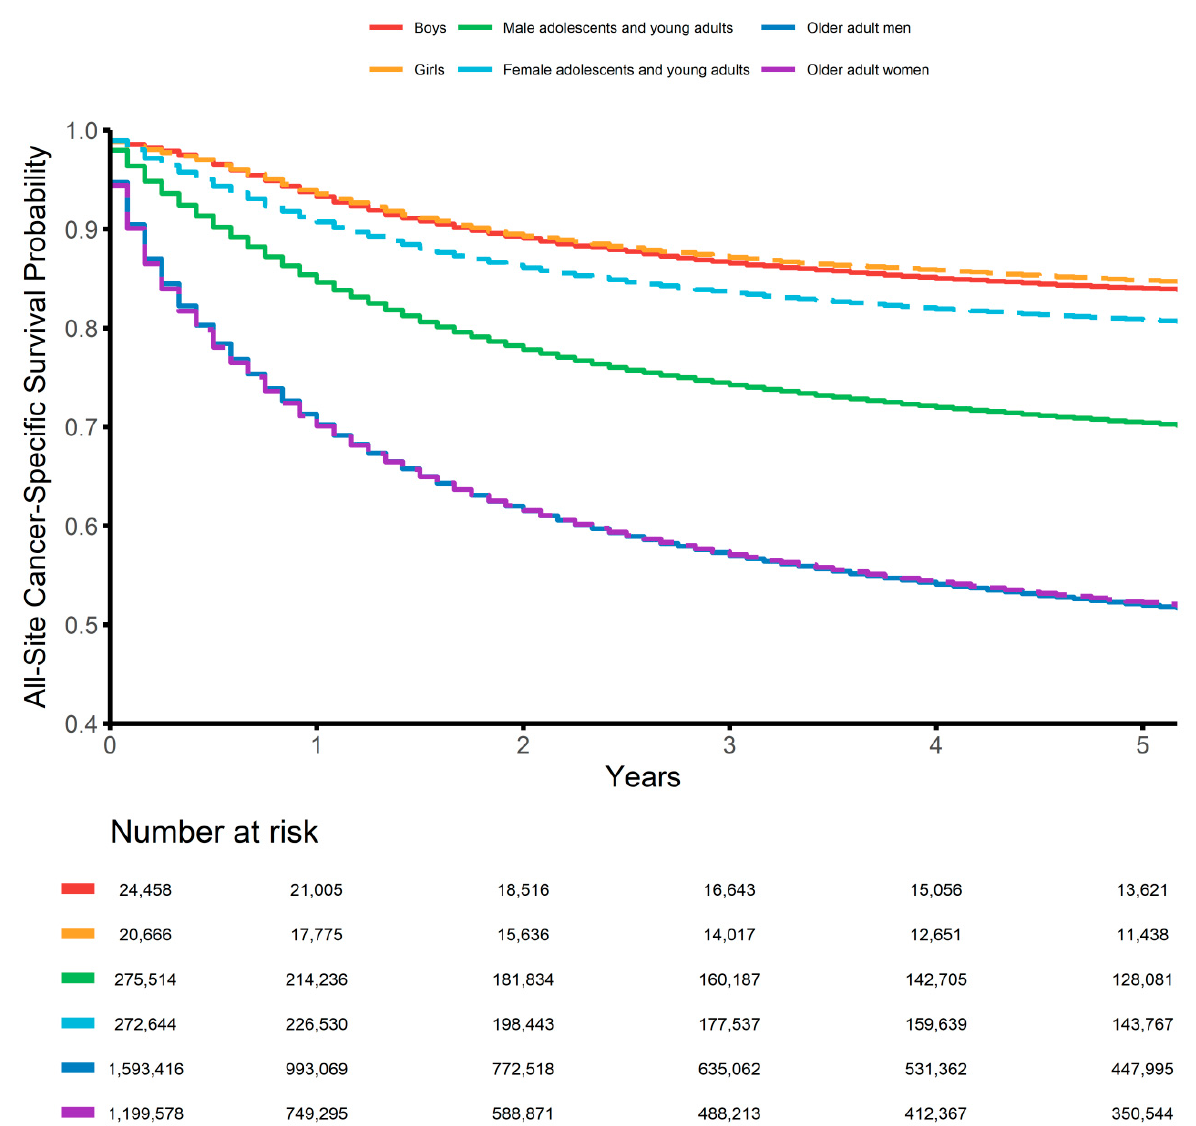
Figure 2. Sex-stratified Kaplan–Meier estimates of the all-site cancer-specific survival proportions of children (<15 years), adolescents and young adults (15–49 years), and older adults ( ≥ 50 years).